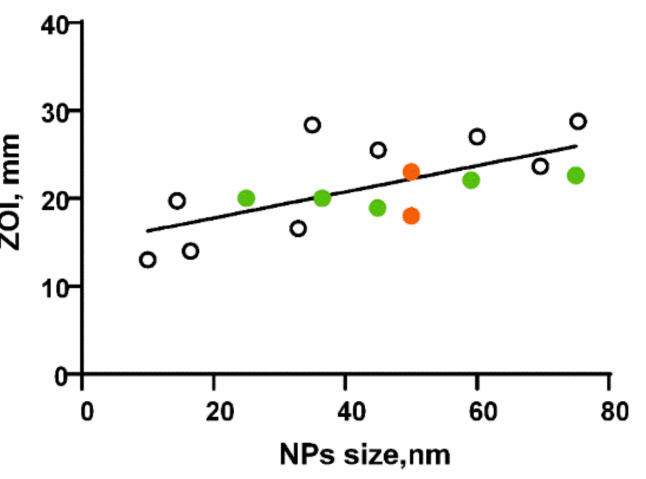
Figure 1. Dependence of the inhibition zone on the AlOxNP size reported in the literature for S. aureus . Green dots-NPs, synthesized using plant extracts; orange dots-NPs, modified with